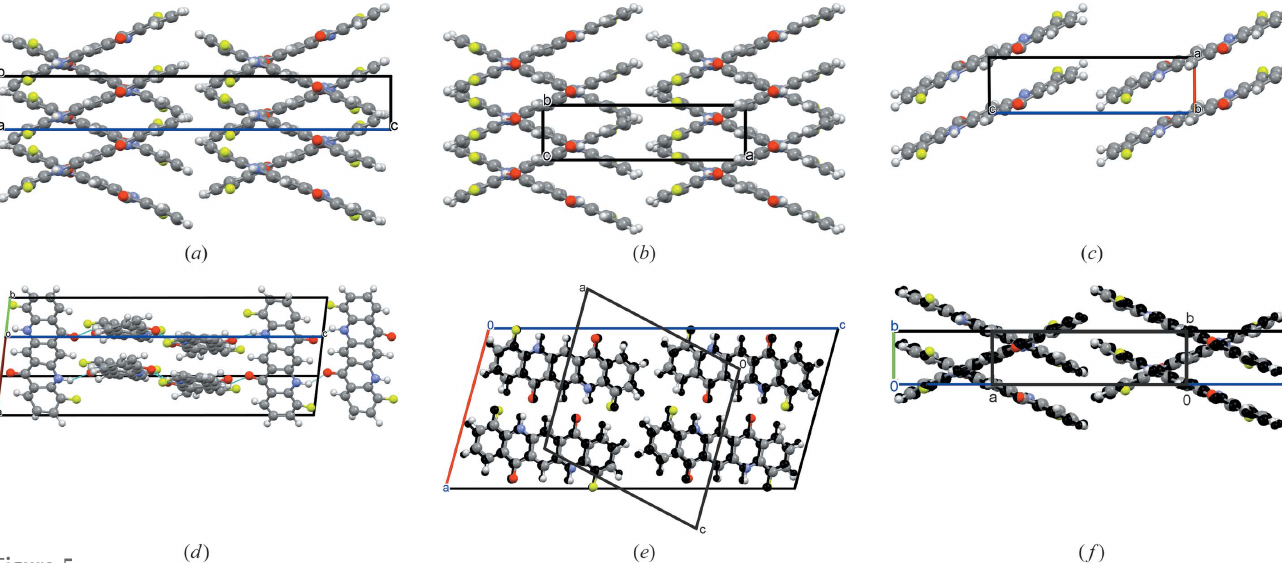
Figure 5 Crystal structures of models ( a ) A, ( b ) B, ( c ) C and ( d ) D, after user-controlled Rietveld refinements. ( e ) Overlay of the models A (coloured) and B (black), view direction [010]. ( f ) Overlay of A (coloured) and B (black), view direction [100] for A and [001] for